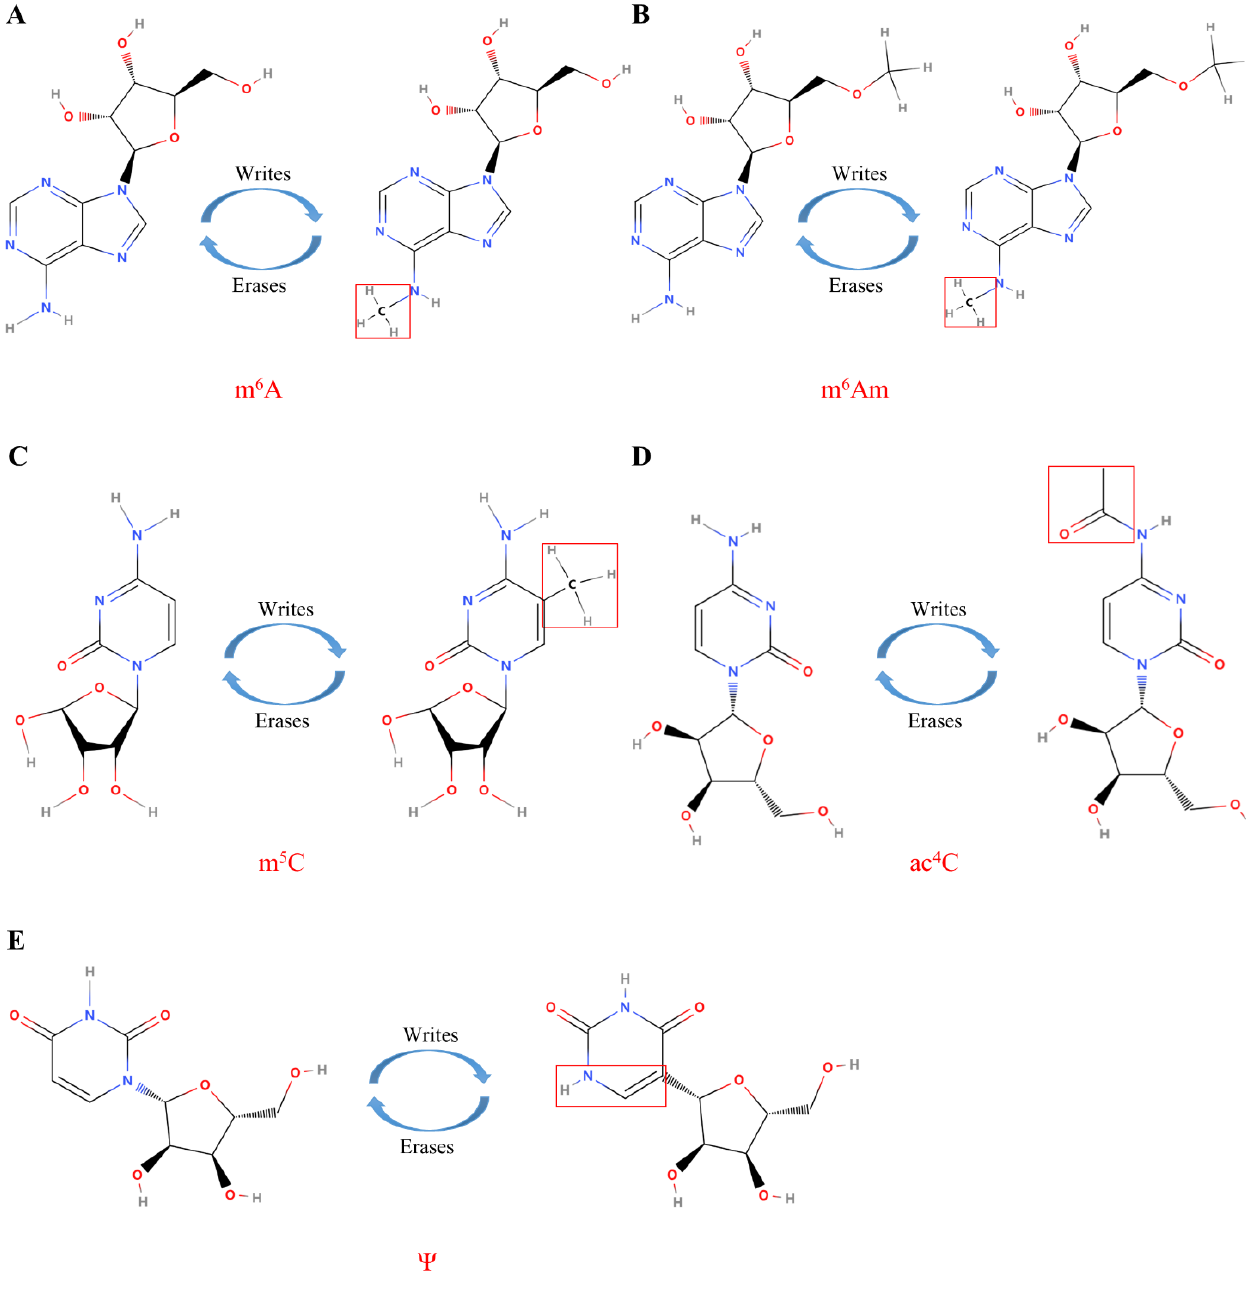
Figure 3. The molecular composition of RNA modifications. ( A ) The m 6 A modification of RNA is mediated by proteins called “writes” and “erases”; ( B ) The m 6 Am modification of RNA is mediated by proteins called “writes” and “erases”; ( C ) The m 5 C modification of RNA is mediated by proteins called “writes” and “erases”; ( D ) The ac 4 C modification of RNA is mediated by proteins called “writes” and “erases”; ( E ) The Ψ modification of RNA is mediated by proteins called “writes” and “erases”. Under the catalysis of the corresponding enzymes, the molecular structure and the enrichment level of RNA are changed to play different biological